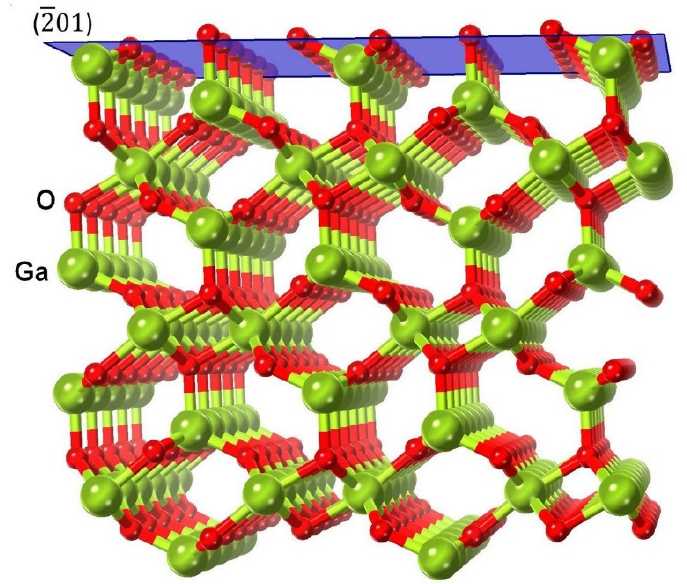
Figure 4. Configuration of atoms in 𝛽 -Ga 2 O 3 . The < 201 > direction is oriented upwards. Large green balls represent Ga atoms; small red balls represent O atoms.